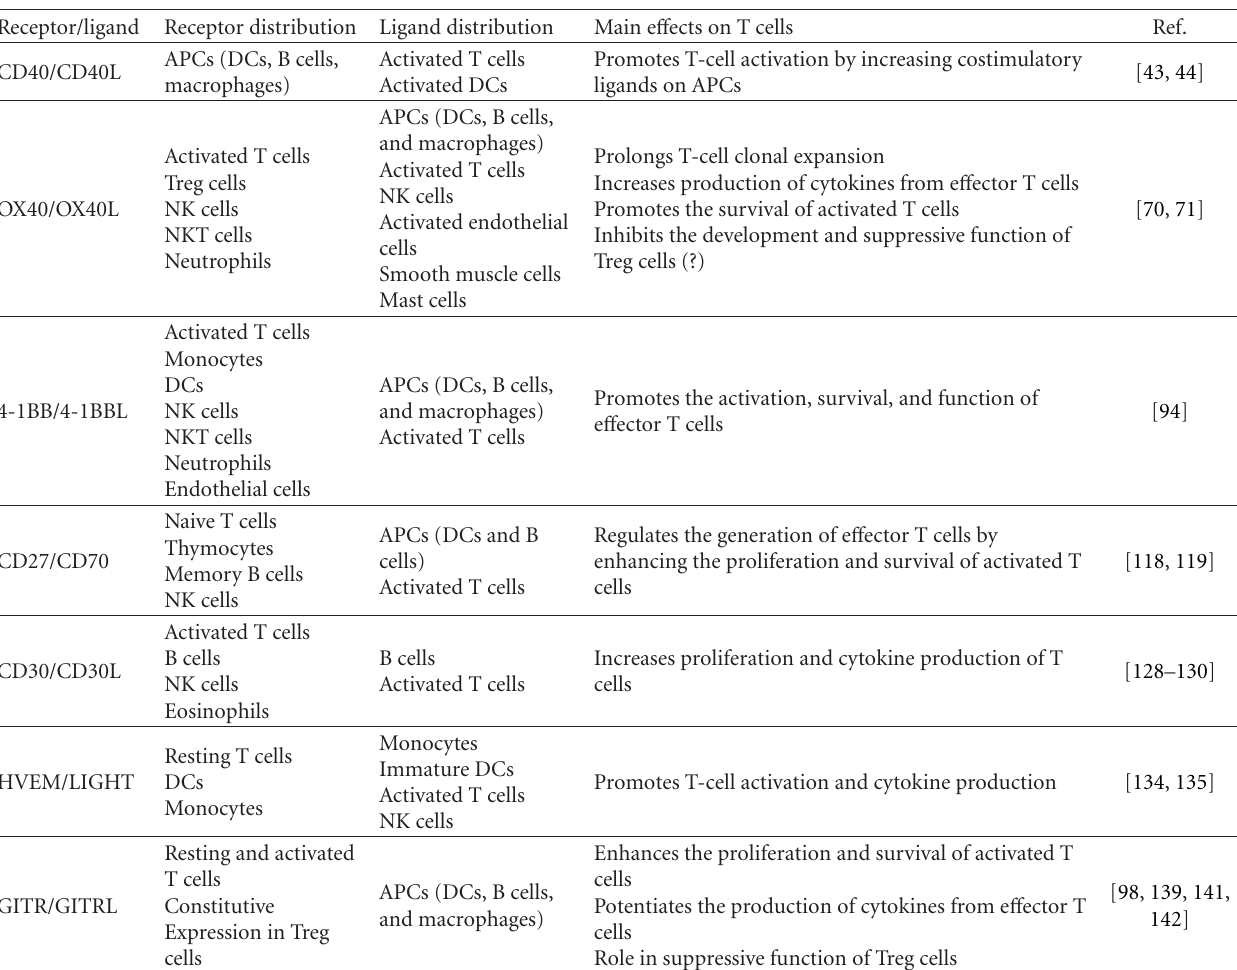
Table 1: Expression and key features of costimulatory TNFR family members in T cells. Receptor/ligand Receptor distribution Ligand distribution Main e ff ects on T cells